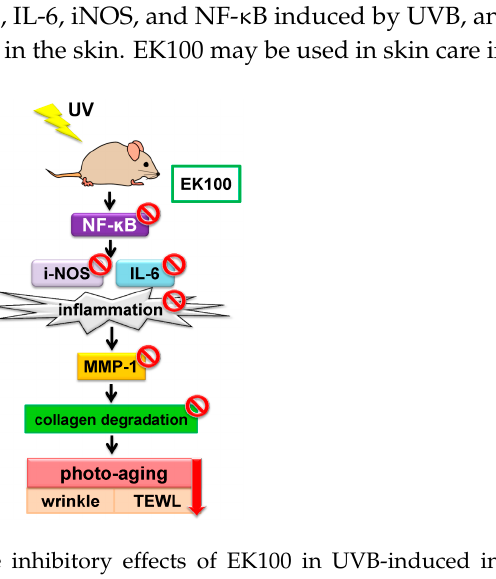
Figure 8. Schematic diagram of the inhibitory effects of EK100 in UVB-induced inflammation and photodamage.